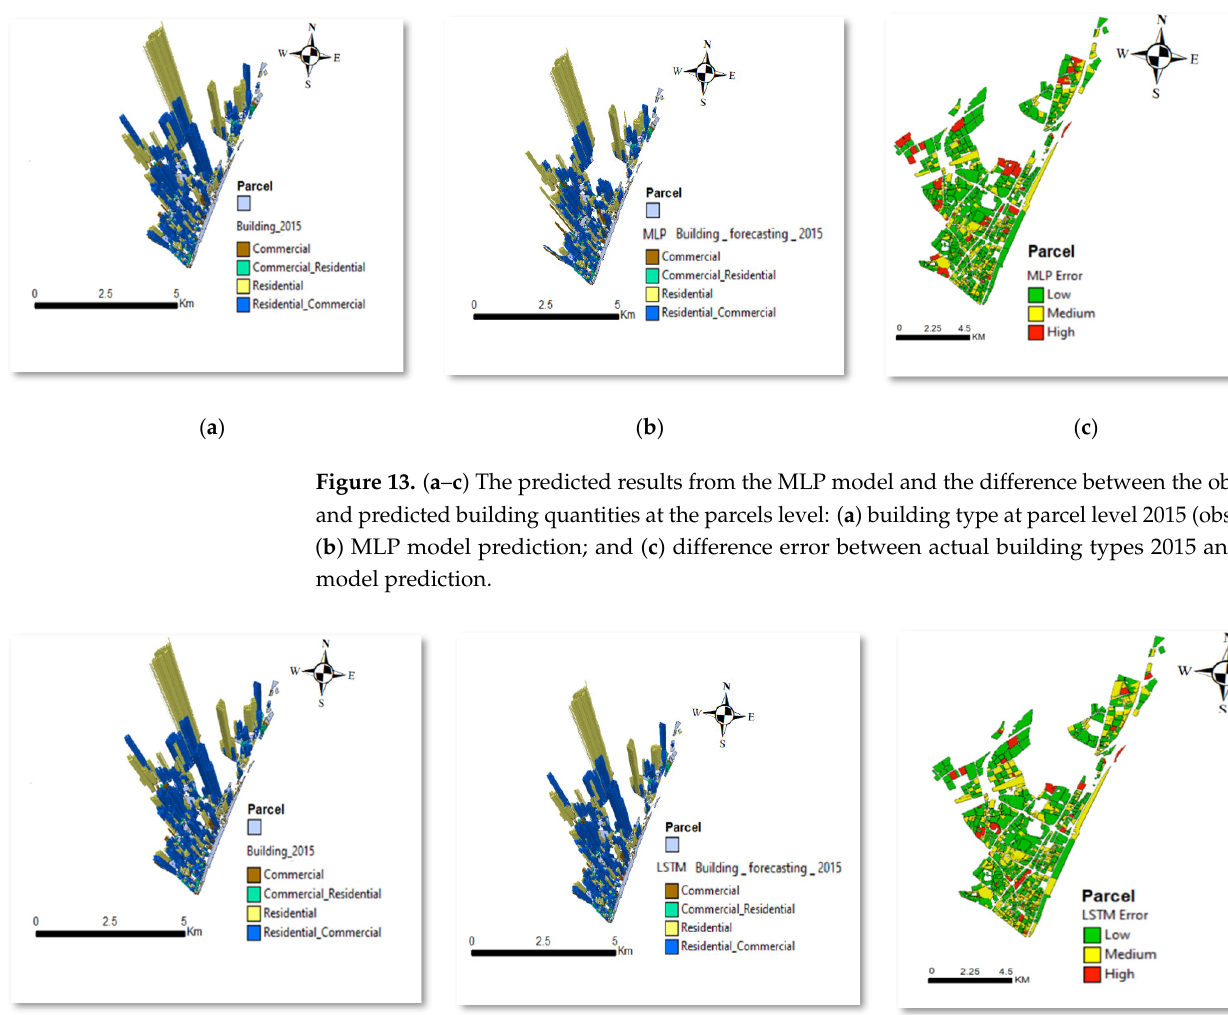
24 of 29 Table 8. Comparison of forecasting errors of MLP and LSTM (testing). Models MLP Testing Errors